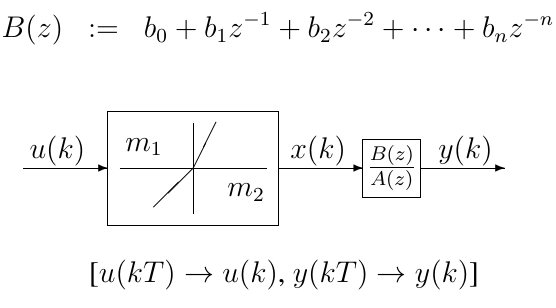
Figure 2. The discrete-time Hammerstein